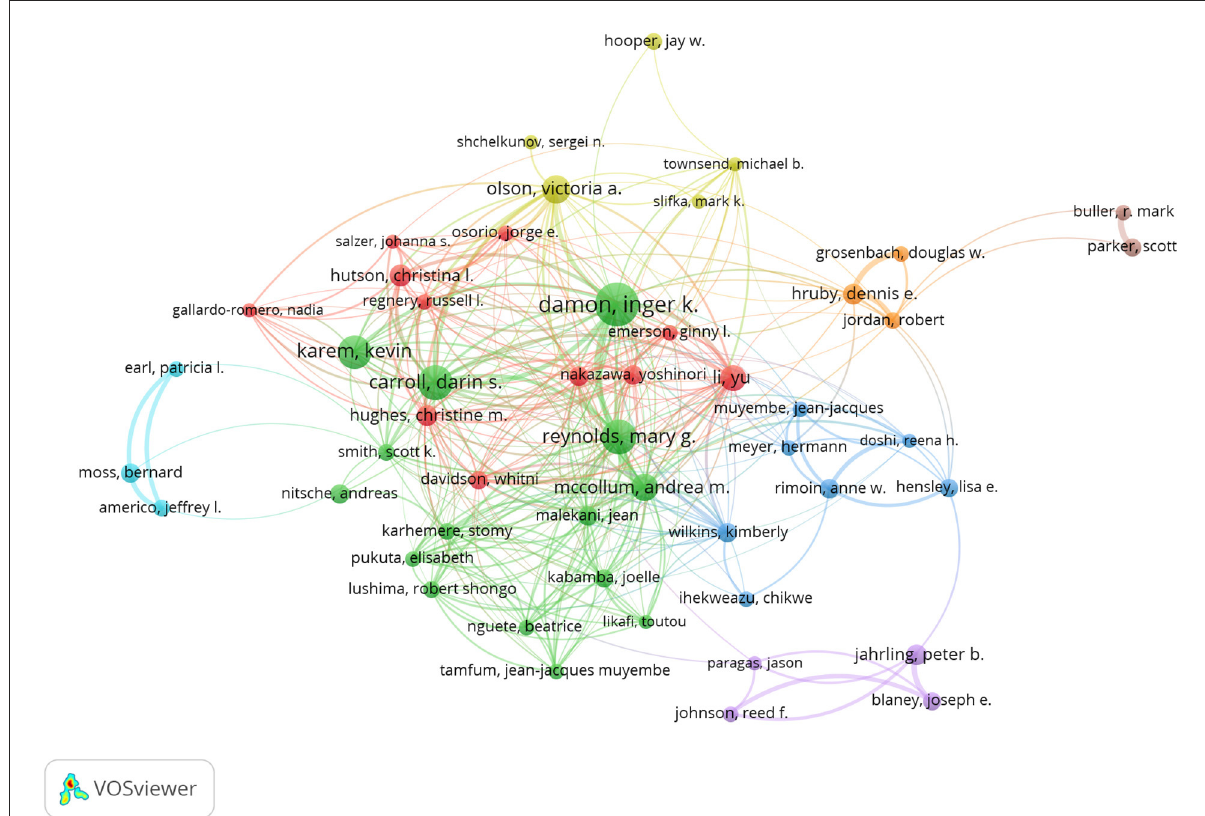
FIGURE3 Author co-authorship overlay visualization map in the field of monkeypox. The author’s minimum document number threshold was set to 10, and 50 authors with high-frequency publications were screened.